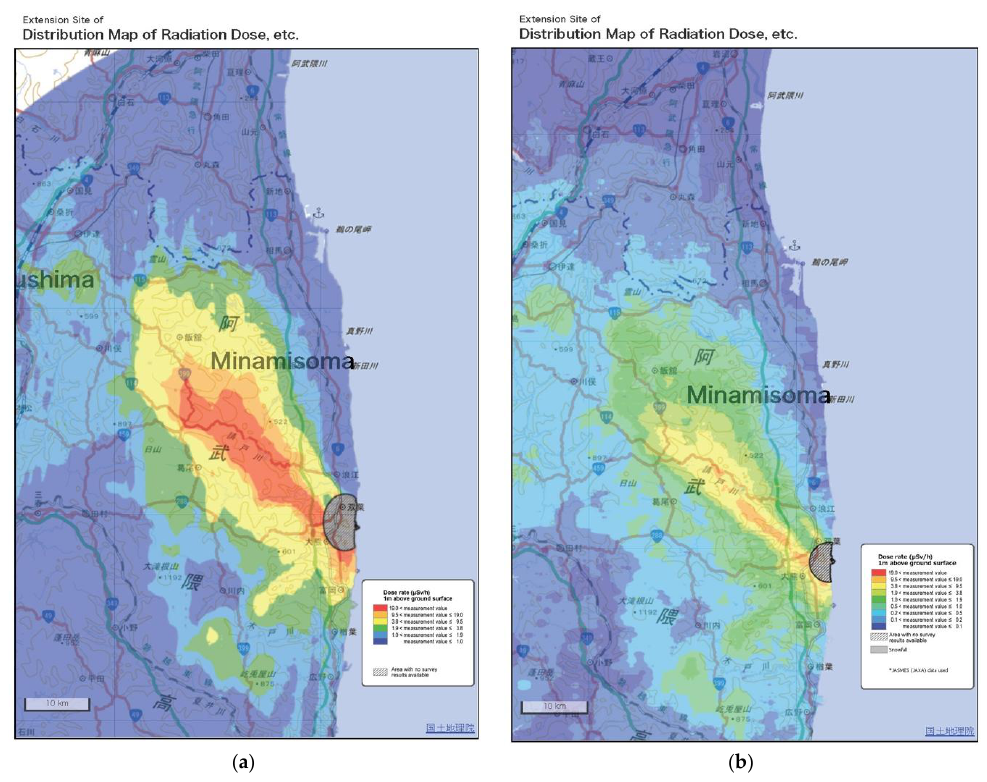
Figure 2. Local dose rates measured in Sv/h ( a ) on 29 April 2011 and ( b ) on 18 November 2016